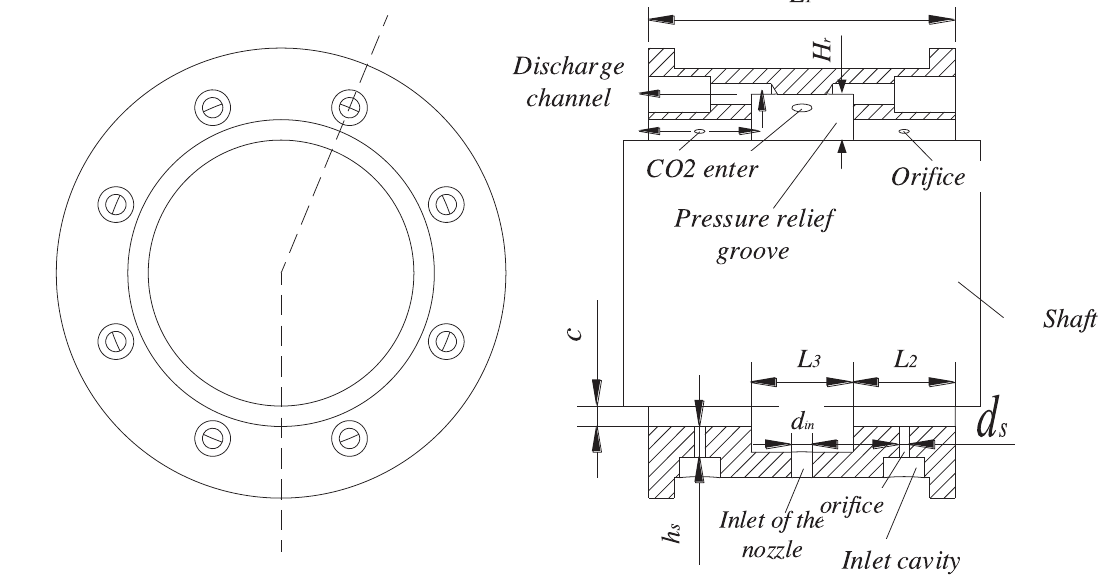
Fig. 4. SCO2 cooling devices treated in this paper. Table 4. Principal dimensions treated in this